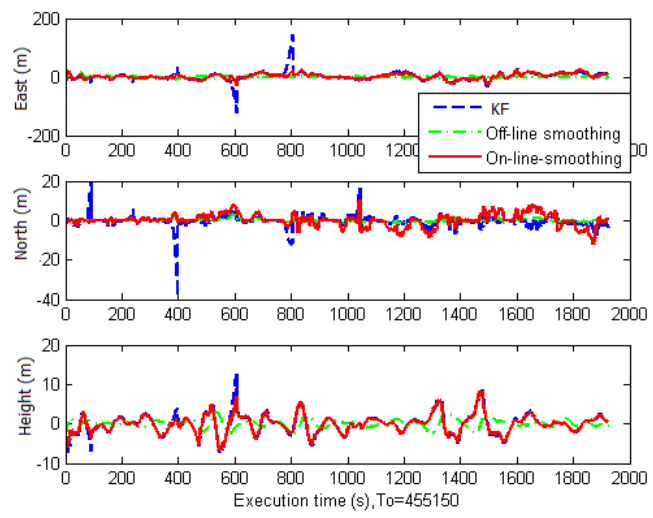
Figure 13. Positional error comparison.